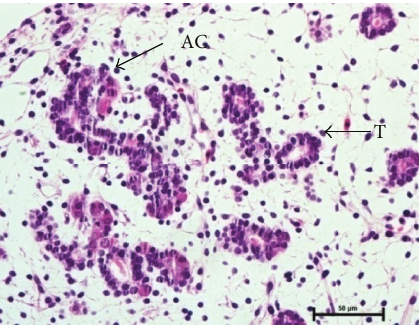
Figure 1: 1.2 cm CVRL (34 days) showing primitive tubules (T) and developing acinar cells (AC) in mesenchyme of pancreas. Hematoxylin and eosin × 400.